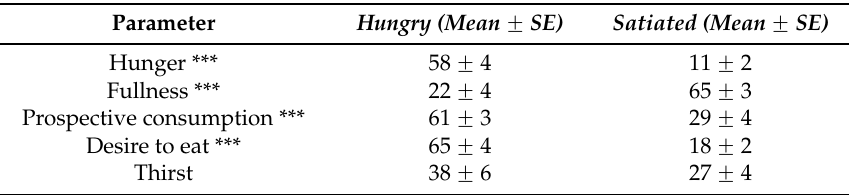
Table 2. Hunger ratings (100 mm VAS) for both hunger